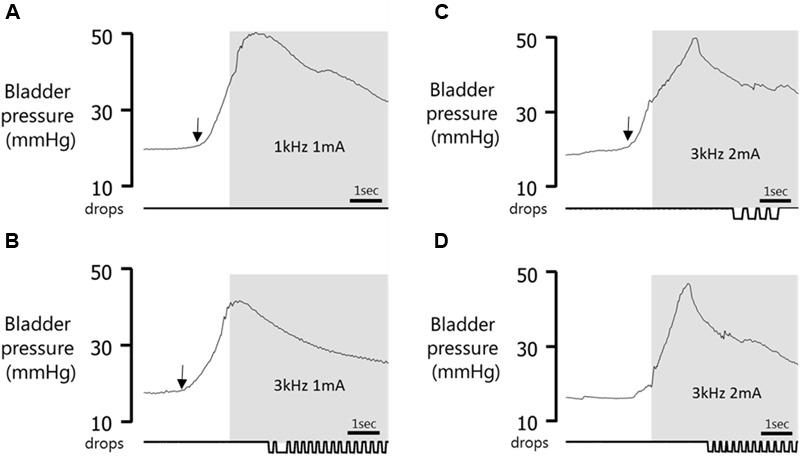
Effect of timing of stimulus onset. Gray panel shows stimulation period. (A) Void suppressed when stimulation was applied 1.13 s after the start of the bladder contraction. (B) No effect on voiding in same experimental session when stimulation was started 1.40 s after the onset of bladder contraction. (C) Void volume reduced (compared to prior spontaneous voids) when pelvic nerve stimulation was initiated 1.01 s after the start of the bladder contraction. (D) Stimulation in error during a spontaneous fluctuation in pressure when bladder nearing capacity induces a rise in bladder pressure and expulsion of urine. Arrow indicates onset of the bladder contraction.